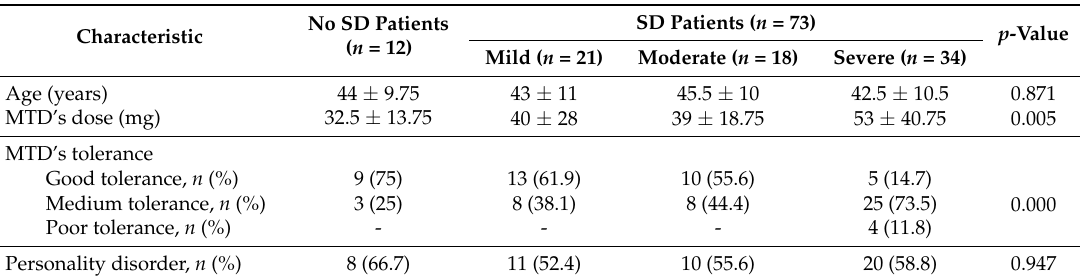
Table 3. Comparison of clinical characteristics between patients with no SD and patients with SD, distinguishing those with mild, moderate, and severe SD.